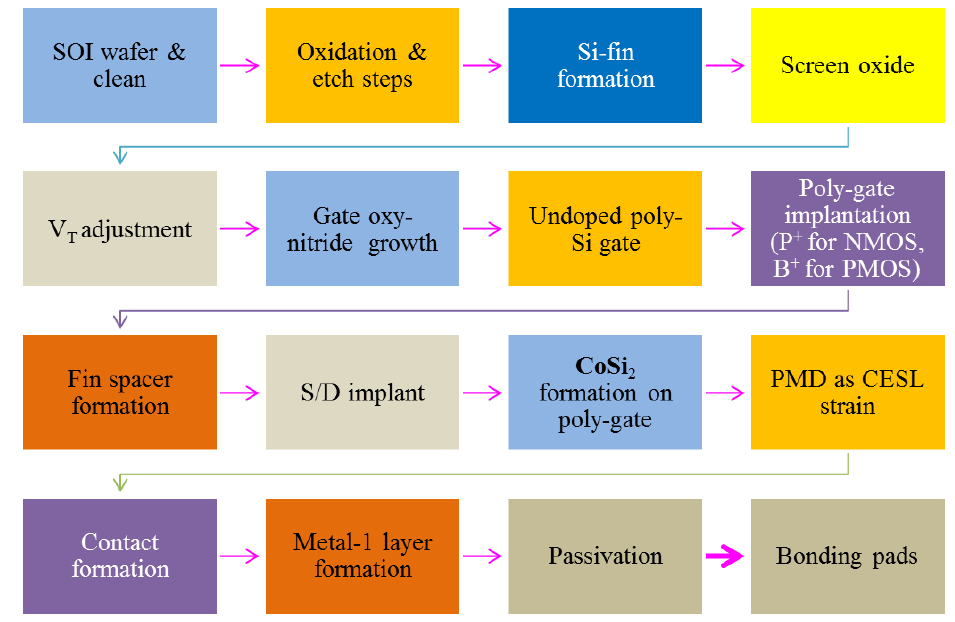
Figure 7. The simple flow chart of FinFET formation.